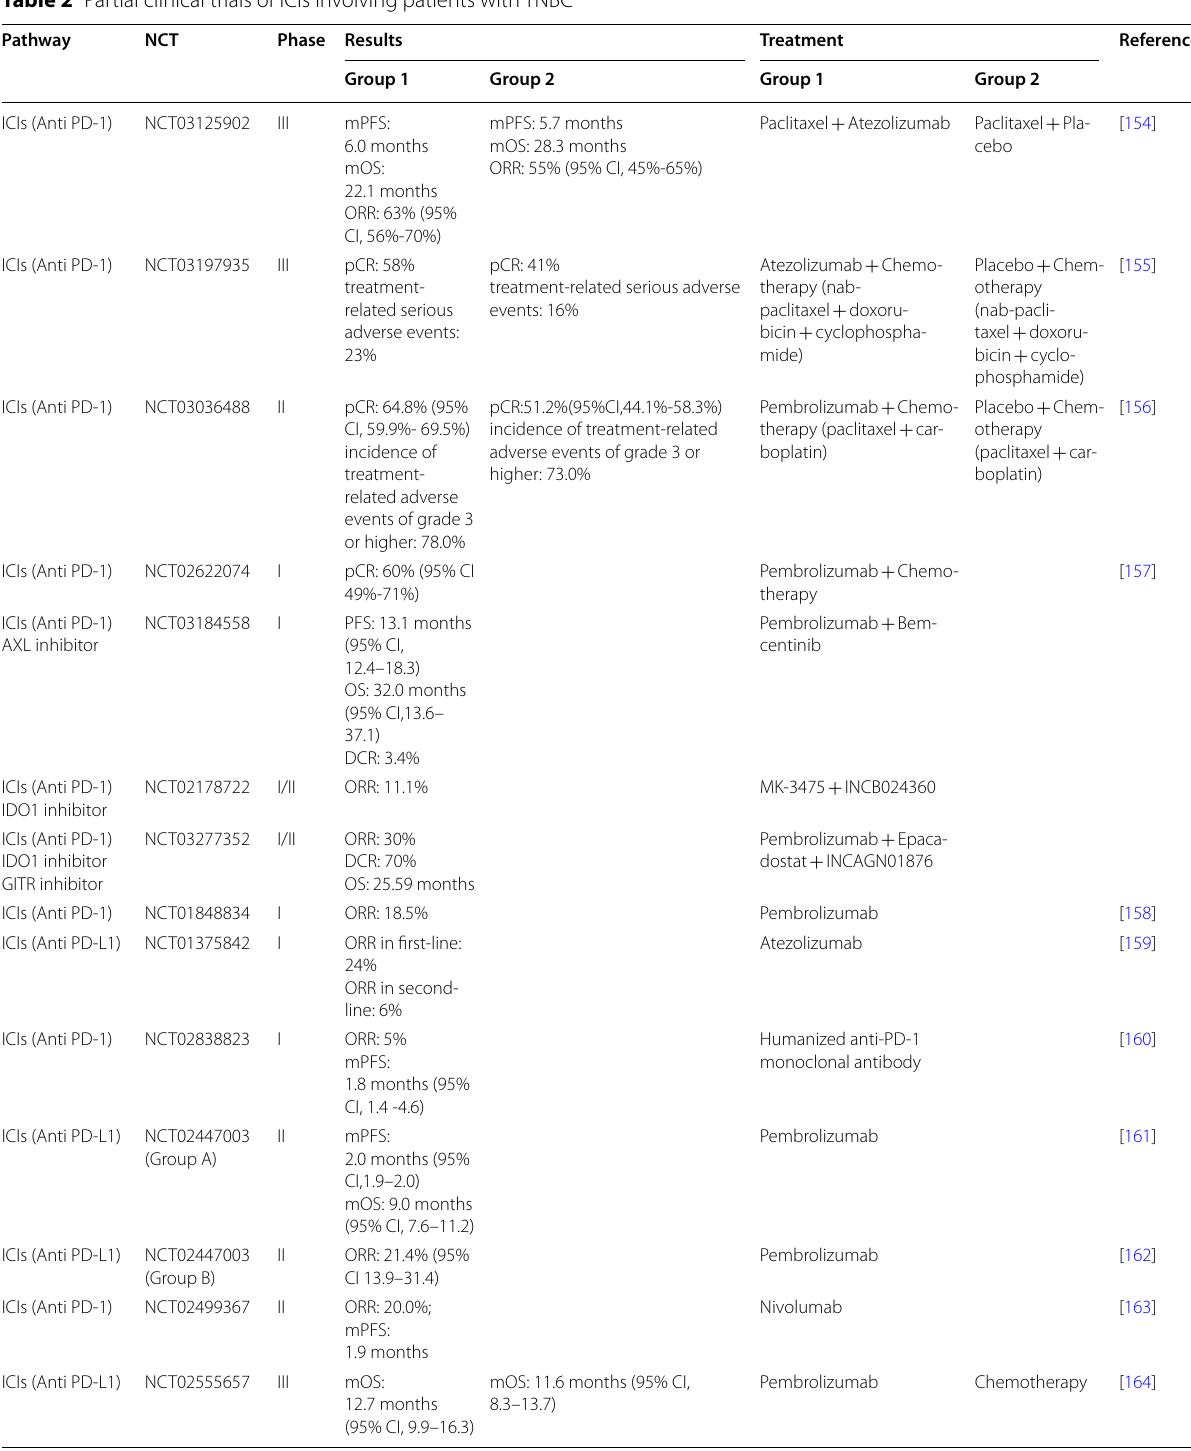
Clinicaltrials.gov, accessed on November 1, 2021